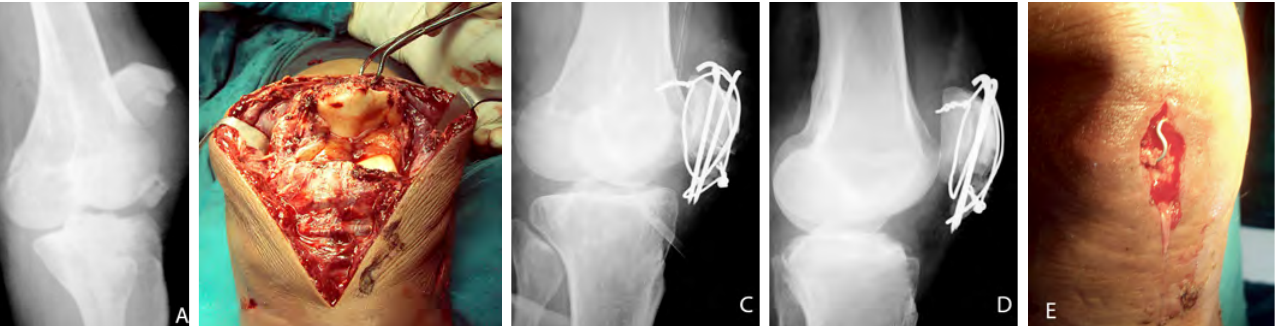
Fig 2 : A 45-year-old man fell from height and sustained a displaced patellar inferior pole fracture; ( A ) Oblique radiograph of the comminuted inferior avulsion fracture without articular extension; ( B ) Intraoperative photograph shows extra-articular location of the fracture with complete disruption of retinaculum; ( C ) Postoperative lateral radiograph shows fracture reduction and internal fixation with TBW and circumferential wiring; ( D,E ) Six months post surgery lateral radiographs shows fracture non union with infection and exposed end of